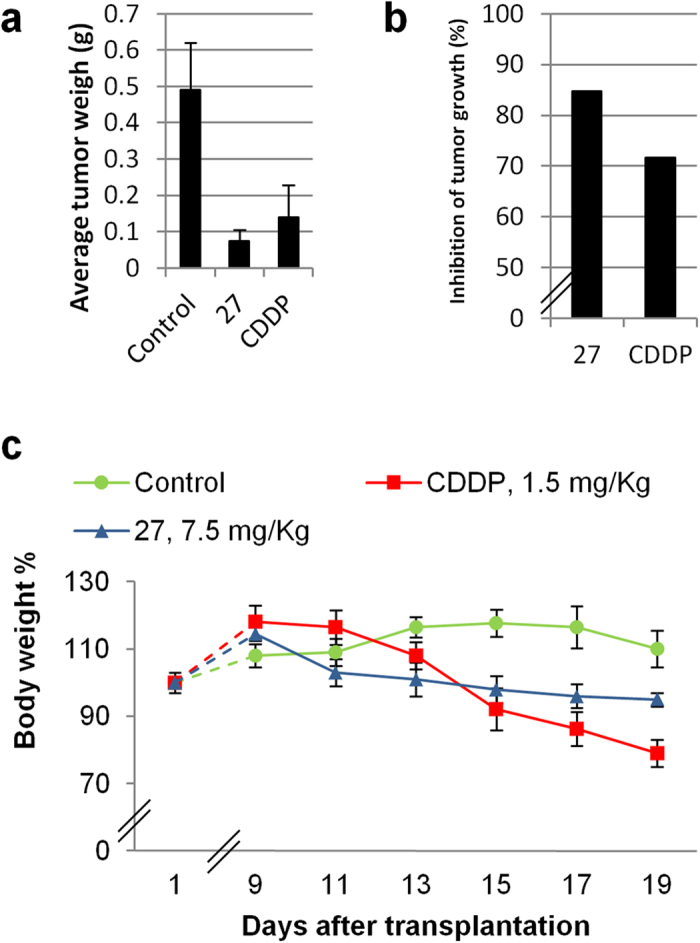
In vivo testing of compound 27.Lewis lung carcinoma (LLC) was implanted i.m. (2 · 106 cells inoculum) into the right hind leg of 8-week old imbred C57BL mice. Nine days after tumor inoculation (palpable tumor), tumor-bearing mice were randomized into vehicle control and treatment groups (8 mice per group). Compound 27 was dosed daily at 7.5 mg/kg ip and CDDP was dosed daily at 1.5 mg/kg ip. At day 20, animals were sacrificed (i.e., before tumor can cause the animal discomfort), the legs were amputated at the proximal end of the femur, and the inhibition of tumor growth was determined according to the difference in weight of the tumor-bearing leg and the healthy leg of the animals expressed as % referred to the control animals. Control was constituted by vehicle (0.2%v/v EtOH and 99.8%v/v of saline solution). CDDP was used as positive reference. Both 27 and CDDP were administered at the highest not toxic doses (7.5 and 1.5 mg/kg, respectively), as determined by MTD studies. (a) Average tumor weight (g) after 20 days of treatment with control or compounds. (b) Percentage of reduction in tumor growth after 20 days of treatment with respect to control mice. (c) Body weight changes. The body weight changes of LLC bearing C57BL mice treated with vehicle or tested compounds. Each drug was administered daily after 9 days from the tumor cell inoculum. Weights were measured at day 1 and daily from day 9. Error bars indicate the standard deviation.